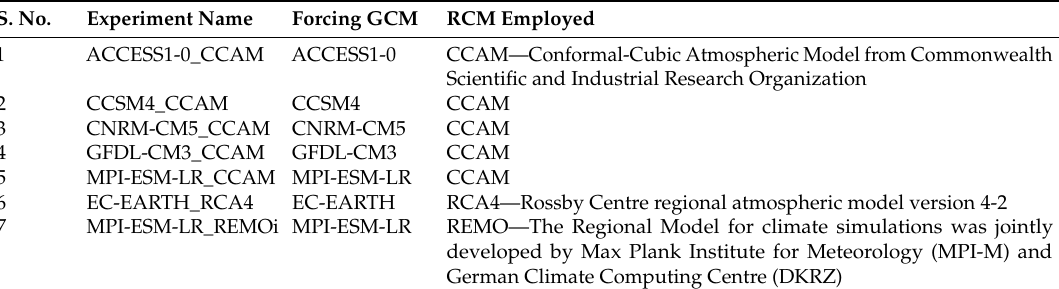
Table 2. The List of seven CORDEX South Asia experiments for RCP8.5 and their CMIP5 forcing. S.